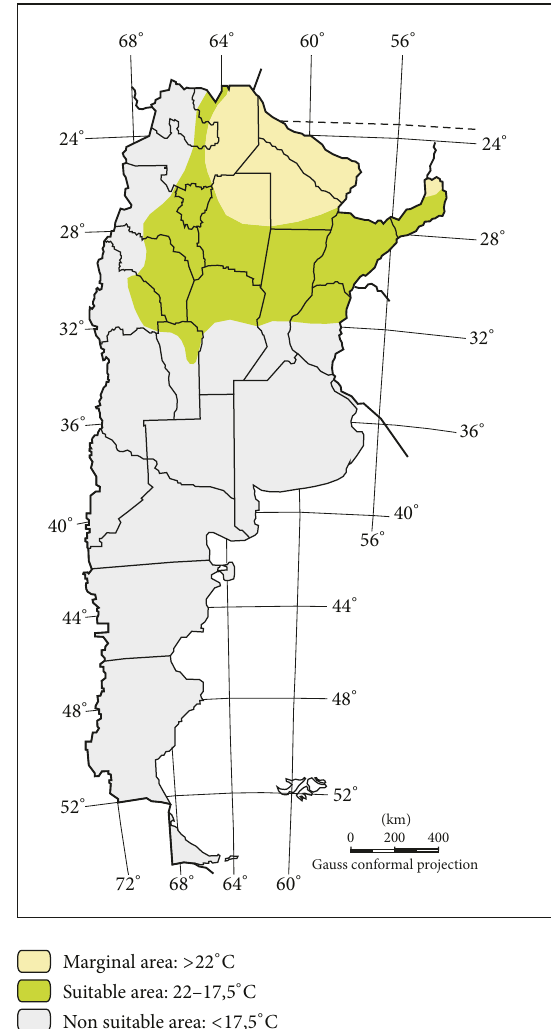
Figure 5: Annual mean minimum temperature.